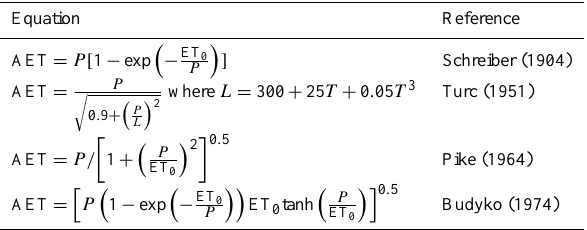
Table 5. Description of different empirical formulas for estimating mean annual actual evapotranspiration: AET is actual